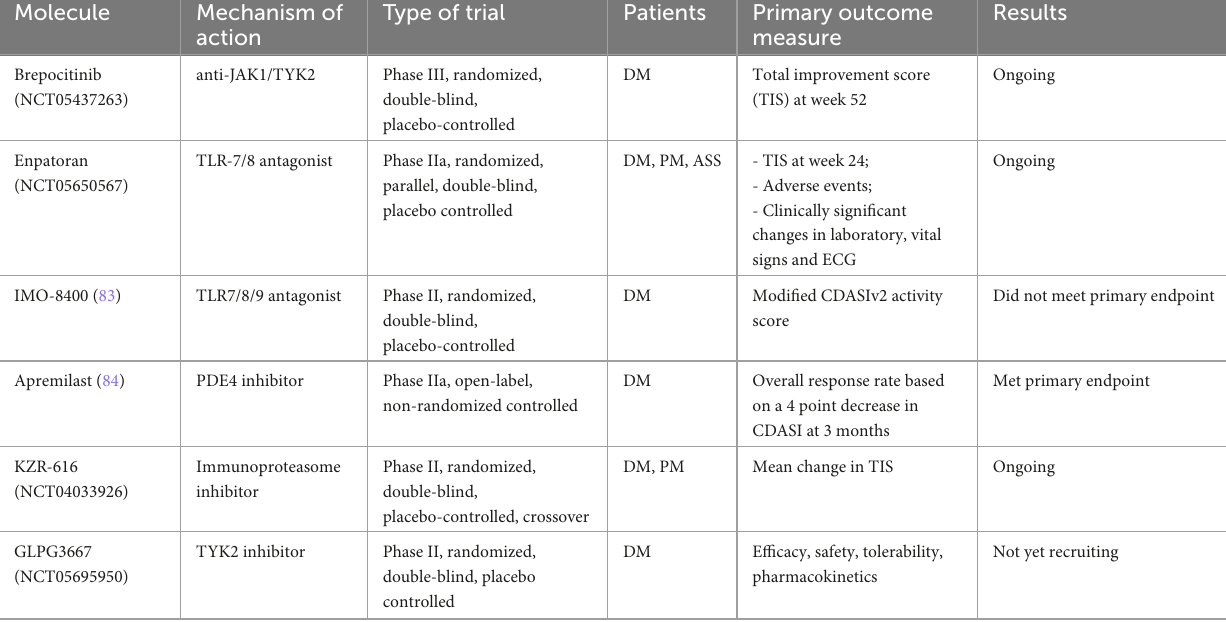
TABLE 2 Recent and ongoing trials investigating new molecules interfering with intracellular pathways in